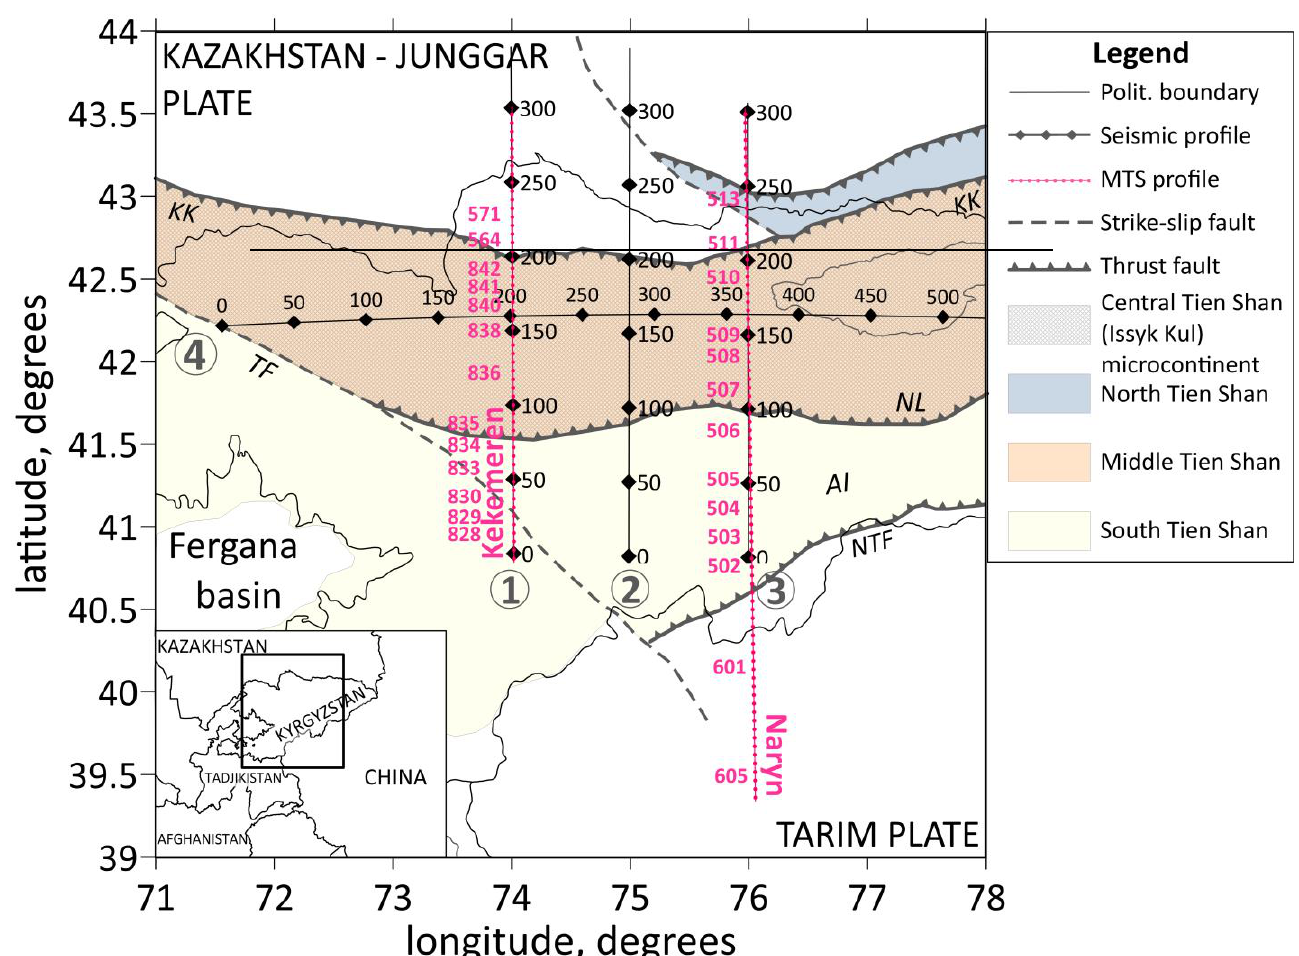
Figure 1. Locations of the geophysical profiles in the study region. The seismic tomography (ST) profiles 1, 2, 3, 4 are highlighted in black, and the magnetotelluric sounding (MTS) profiles are in pink: 1—Kekemeren, 3—Naryn. Main fault structures: TF—Talas–Fergana Fault, NL—Nikolaev Line Fault, AI—At–Bashy–Inylchek Fault, KK—Kyrgyz–Kungei Fault, NTF—North Tarim Fault.